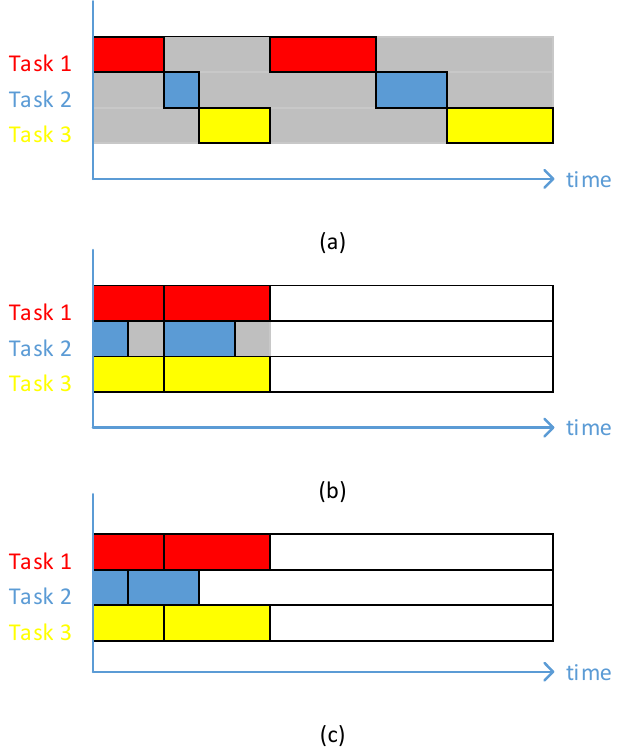
Figure 8. Communication between nodes in improved Pool model.